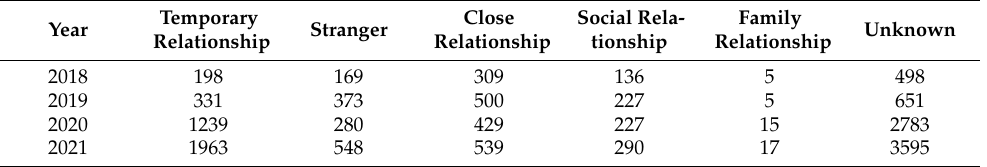
Table 4. Relationship between victims and perpetrators by year.